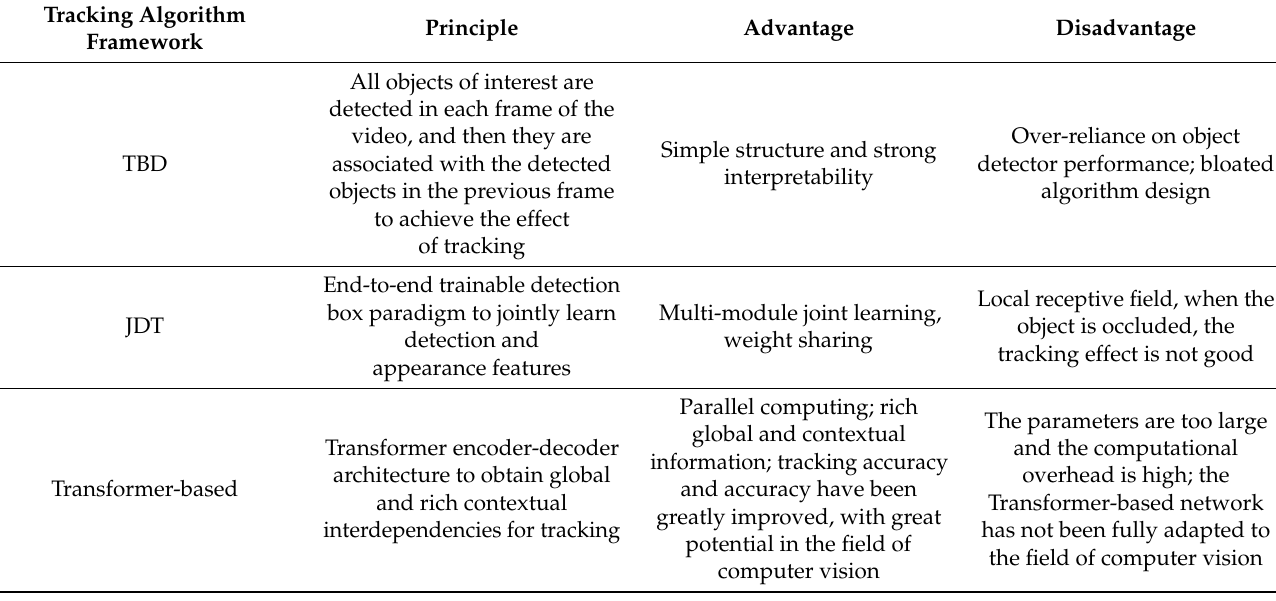
Table 2. Comparison of characteristics of three types of visual multi-object tracking algorithms. Tracking Algorithm